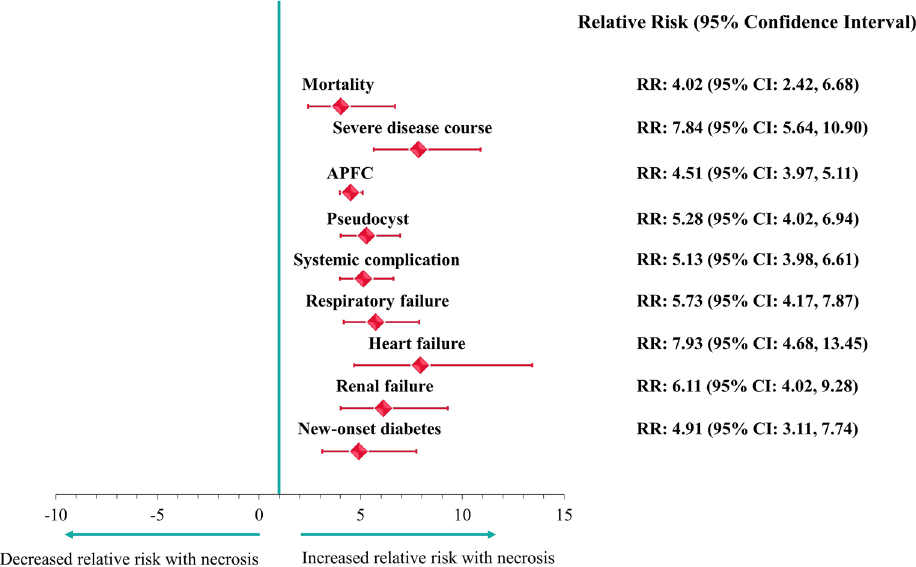
Figure 2. Association between necrosis development and other complications in acute pancreatitis.